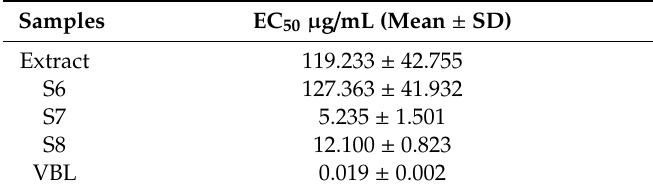
Table 1. Biological activity was expressed in E ff ective Concentration EC 50 values ± SD.